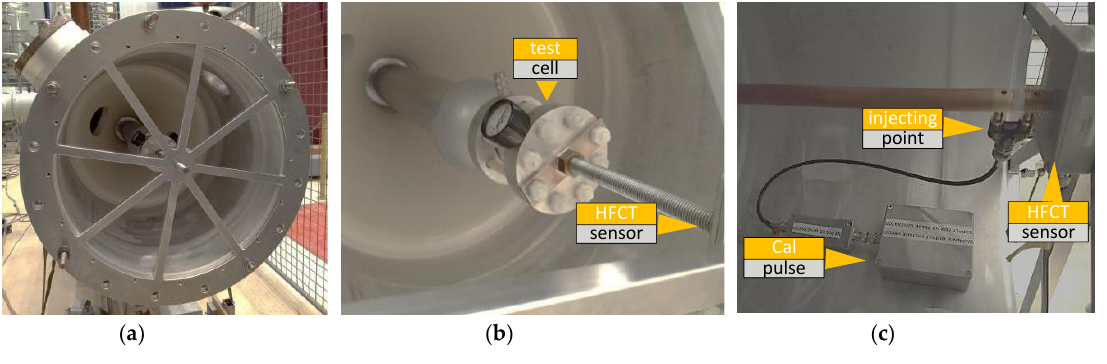
Figure 2. Gas insulated system (GIS) end, ( a ) ground electrode; ( b ) positioning of the test cell and sensor; ( c ) positioning of pulse calibrator.